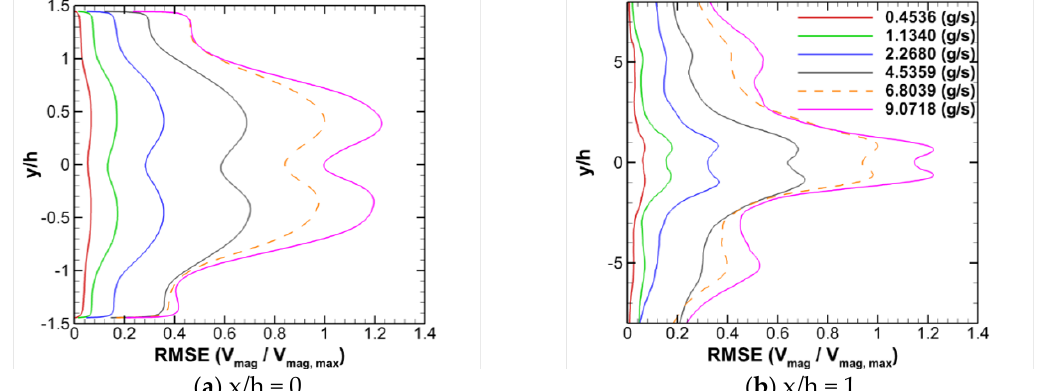
Figure 11. Comparison of RMSE velocity magnitude profiles at ( a ) x/h = 0 and ( b ) x/h = 1. The maximum value of RMSE velocity magnitude at x/h = 0 is 102.1 m/s x/h =1 is 84.6 m/s for the mass of flow rate of 6.8039 g/s.